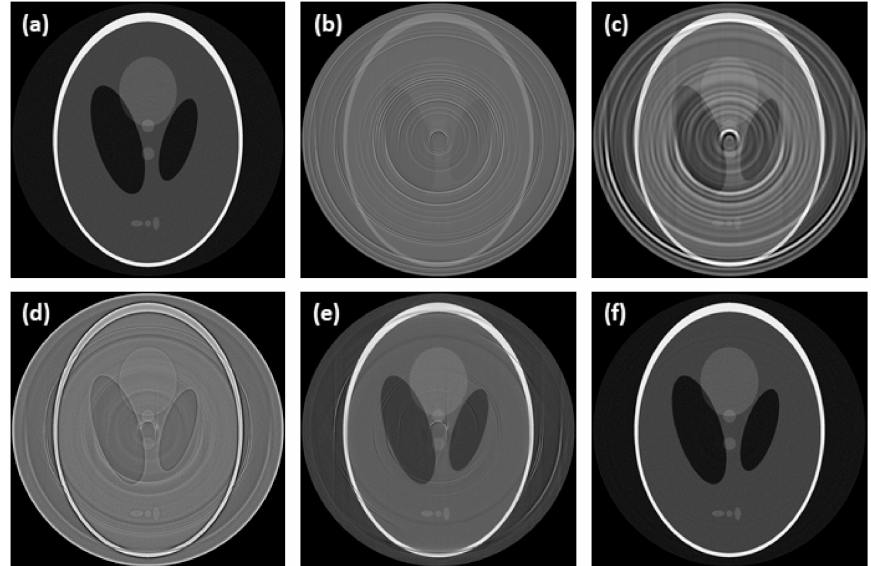
Figure 8. Comparison of tomograms after ring artifacts reduction by tested methods—simulated data of Shepp-Logan phantom: ( a ) reference; ( b ) original (without any correction); ( c ) M1; ( d ) M2; ( e ) M3; ( f ) proposed. For visualization, the same contrast setting was used for all the